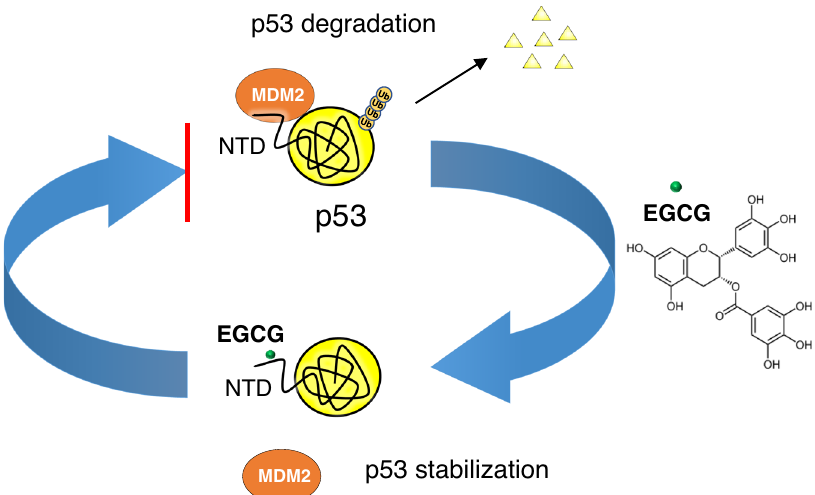
Fig. 7 EGCG disrupts p53 – MDM2 interaction by binding to the N-terminus of p53. The EGCG – p53 interaction disrupts p53 interaction with its regulatory E3 ligase MDM2 and inhibits the ubiquitination of p53 by MDM2, likely stabilizing p53 for anti-tumor